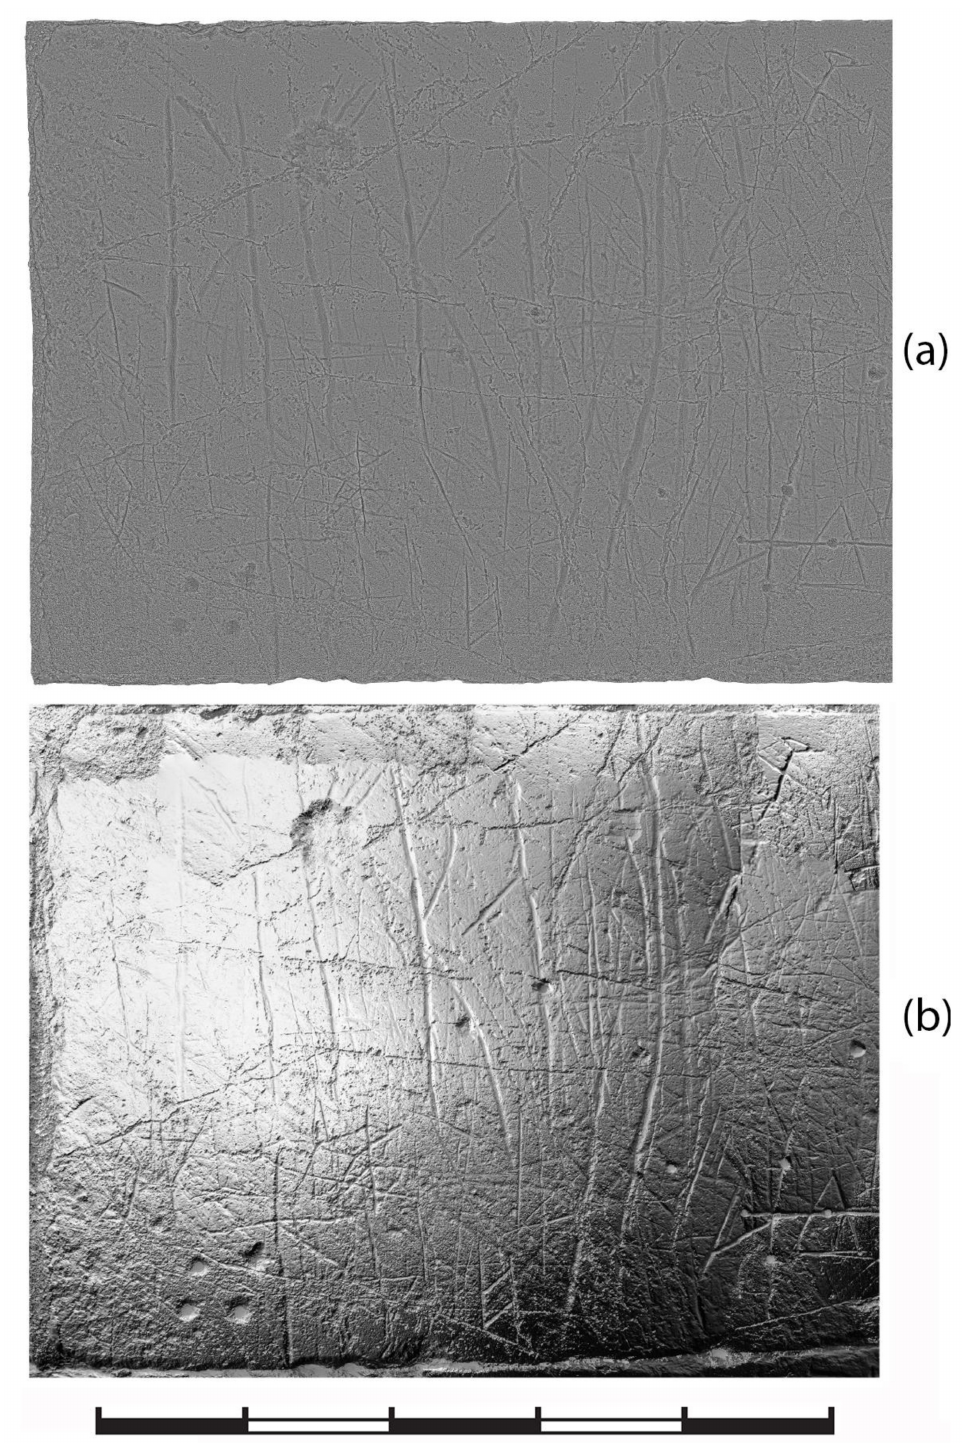
Figure 4. Surface B; ( a ) Combo 1RC and ( b ) a 2D collage of the RL-RTI models, made by photomerging the greyscale Normals Visualizations exports from RTIViewer in Photoshop The RL-RTI models are the most detailed, while the Combo 1 model is the most detailed of the 3D models. The scale shown is 25 cm. For practical purposes, only a selection of the results is shown here. All result images, including of the remaining methods, are available in full resolution